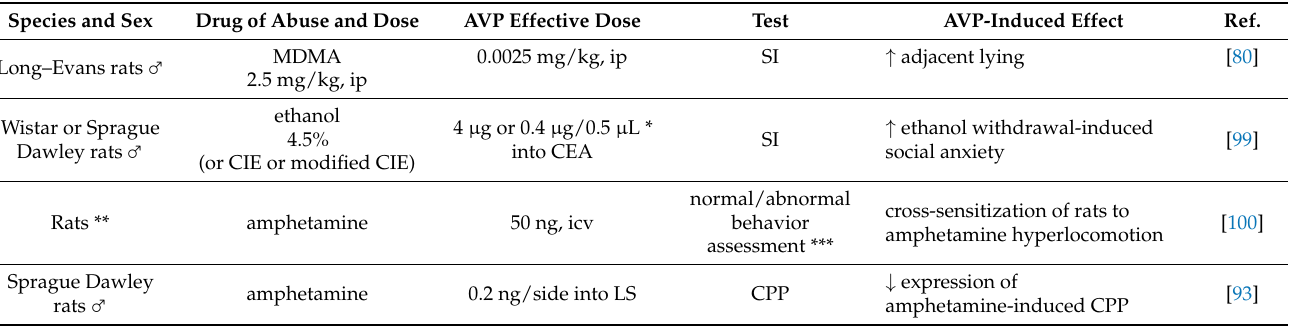
Table 3. The effects of AVP on behavioral/rewarding effects of different drugs of abuse.